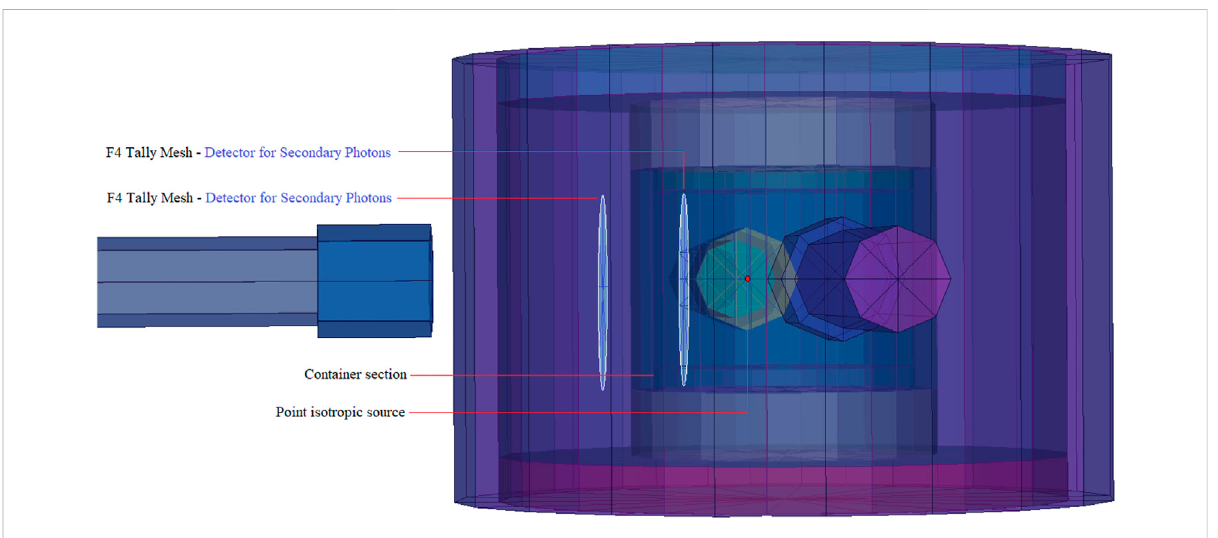
FIGURE 3 Modelled setup for transmission factors (TFs) calculations.